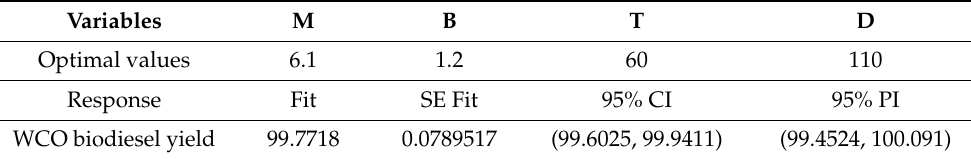
Table 14. Determination of the optimal response for the transesterification process of WCO by the RSM